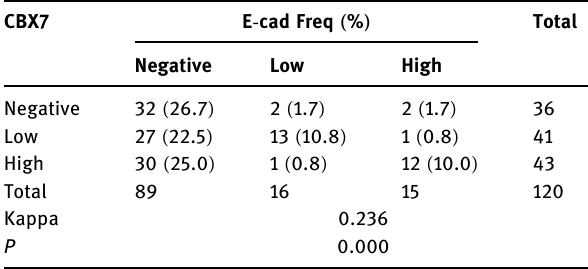
Table 4: Correlation between CBX7 and E - cad